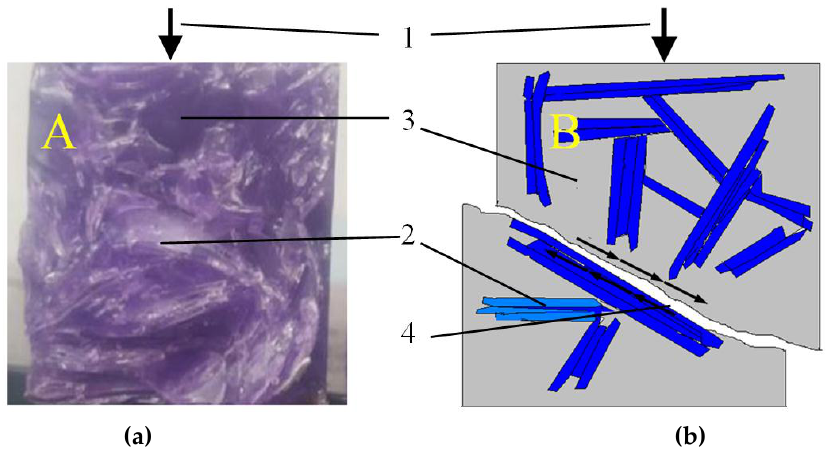
Figure 7. Destruction of the CG-100 Sample Due to Compressive Stress: ( a ) Sample Fracture; ( b ) Scheme of Destruction Due to the Shear at the Interface of the RGA Grain–Polymer matrix; 1 – compressive force direction; 2 – SGA grain; 3 – polymer matrix; 4 – zone of destruction.